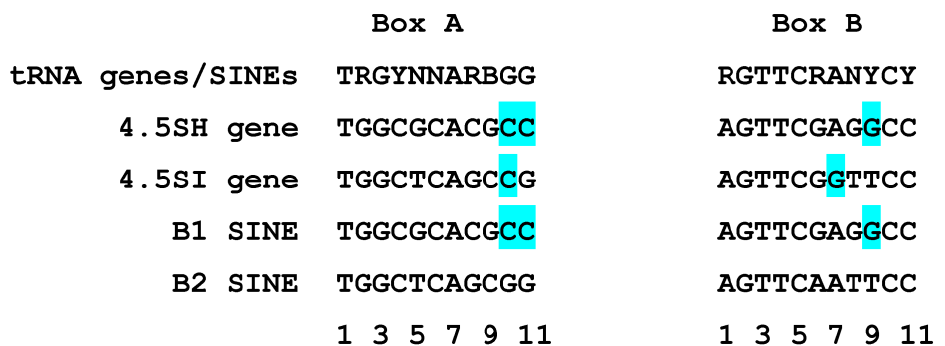
tor. The nucleotides replaced to match the box A or box B consensus sequences are highlighted in Figure 3. Nucleotide sequences of boxes A and B of 4.5SH and 4.5SI RNA genes, as well as B1 and red. The trinucleotide in box B marked in magenta was replaced to reduce promoter activity. B2 SINEs. The consensus sequences of boxes A and B of tRNA genes and SINEs [7,9] are shown above, and the nucleotide numbers are shown below. The nucleotides not matching the consensus boxes are highlighted in blue.